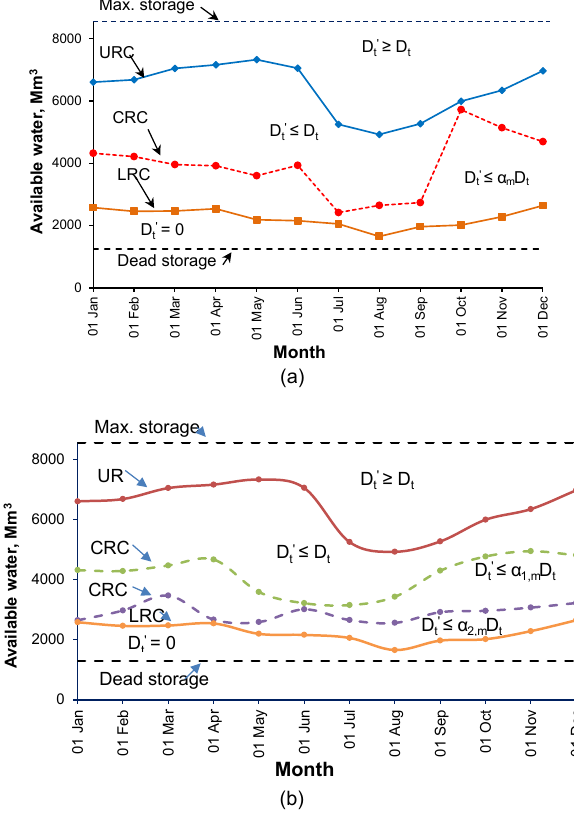
Figure 6. GA optimised rule curves (a) Single-stage monthly vary- ing hedging; (b) two-stage monthly varying